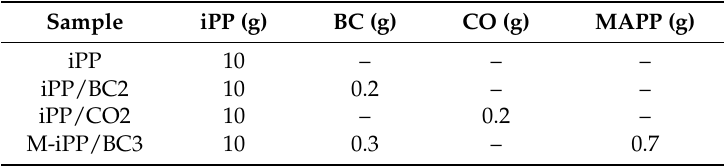
Table 1. Formula of the iPP/BC